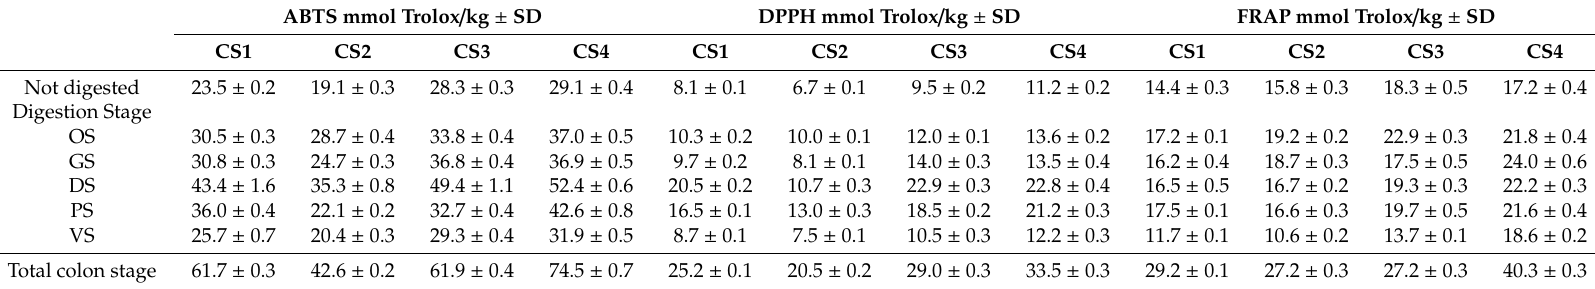
Table 6. Antioxidant activity of digested samples evaluated by ABTS, DPPH, and FRAP assays expressed as mmol Trolox / kg of CS extract.